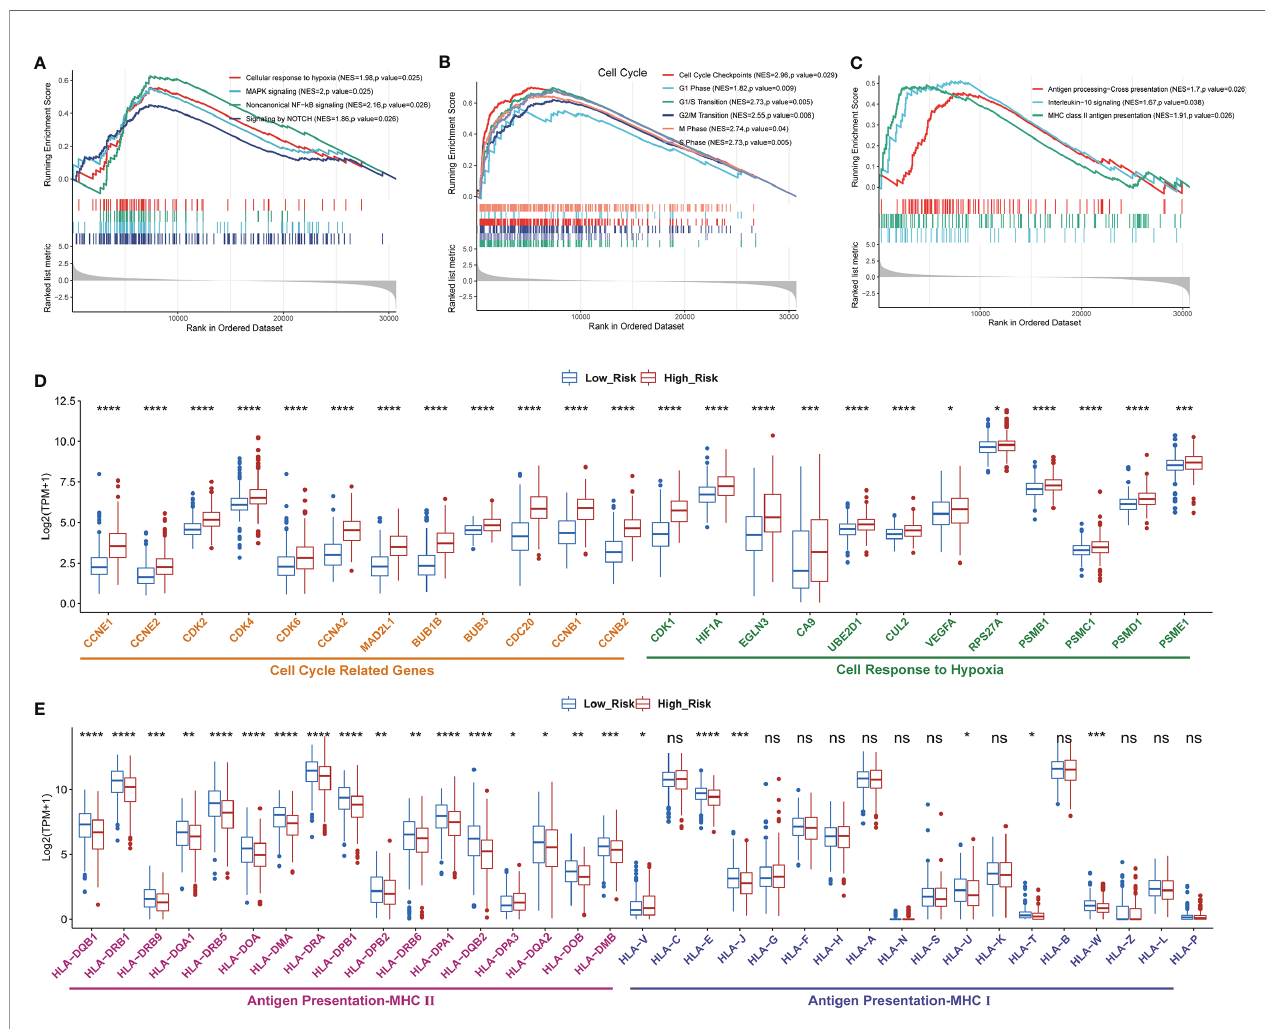
FIGURE 4 | Enriched proliferation-related and cell cycle pathways, but reduced immune-related pathways in the high- as compared to the low-risk group classi fi ed by GDPLichi. GSEA plots of proliferation-related pathways (A) , cell cycle, (B) , and immune-related pathways (C) . All transcripts are ranked by the fold change between low- and high-risk subgroups in the TCGA-LUAD cohort. (D, E) The difference in the expression of cell cycle-related, cell response to hypoxia, and antigen presentation genes between low and high-risk subgroups. *P < 0.05; **P < 0.01; ***P < 0.001; ****P < 0.0001; ns, no signi fi cant